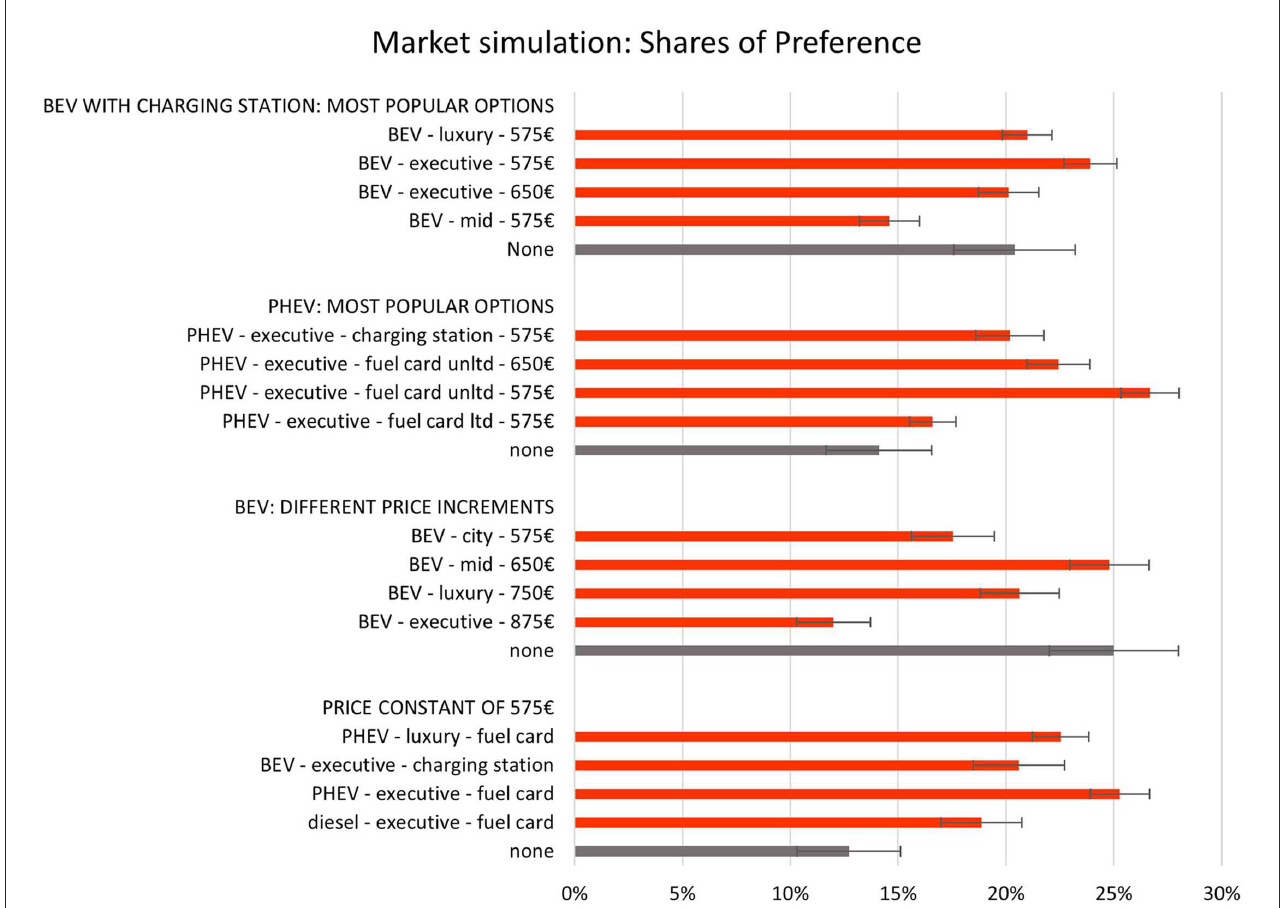
FIGURE5 Market simulations showing preference shares among four categories, including the none-option.